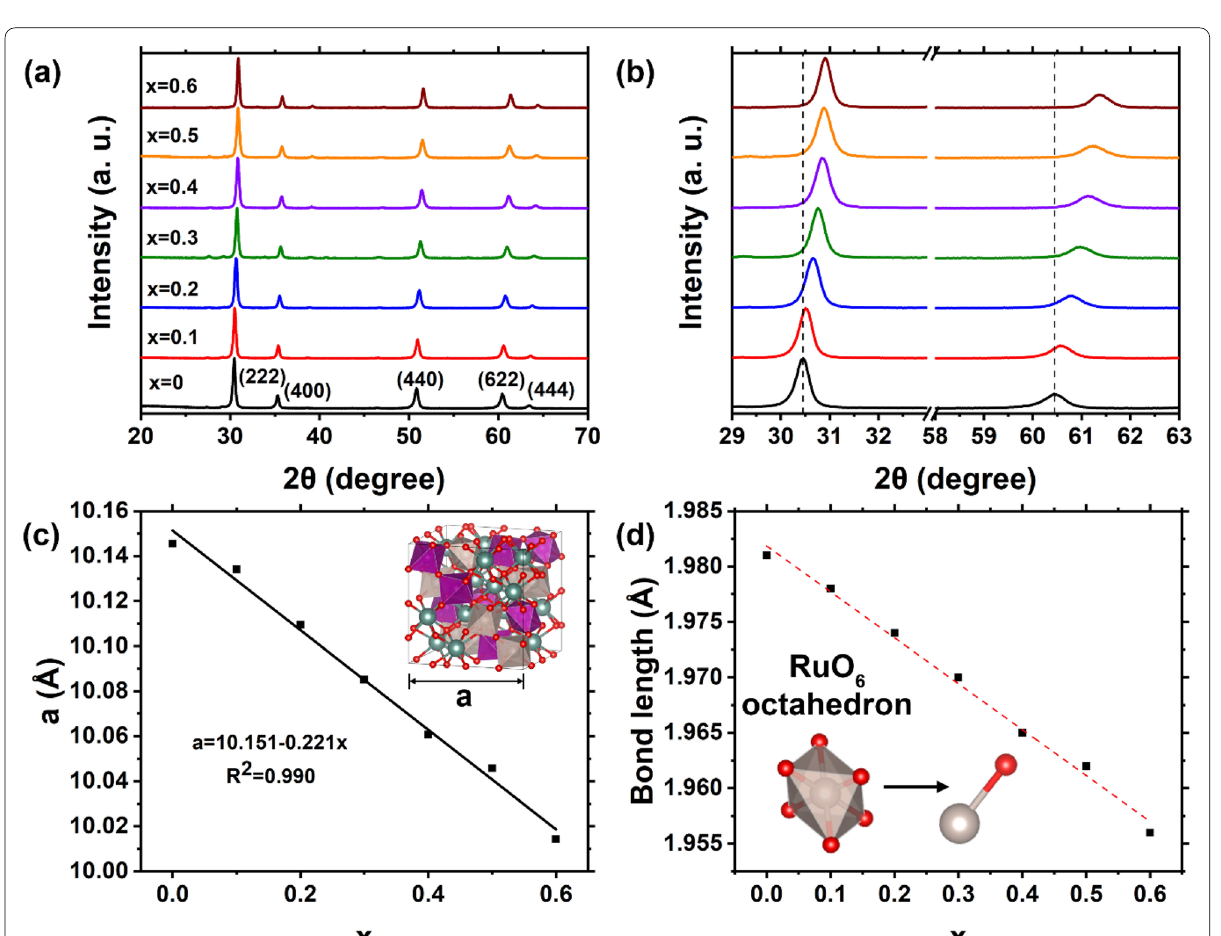
Fig. 4 a , b XRD patterns, c lattice parameter and d Ru-O bond length of YMRO-x (x